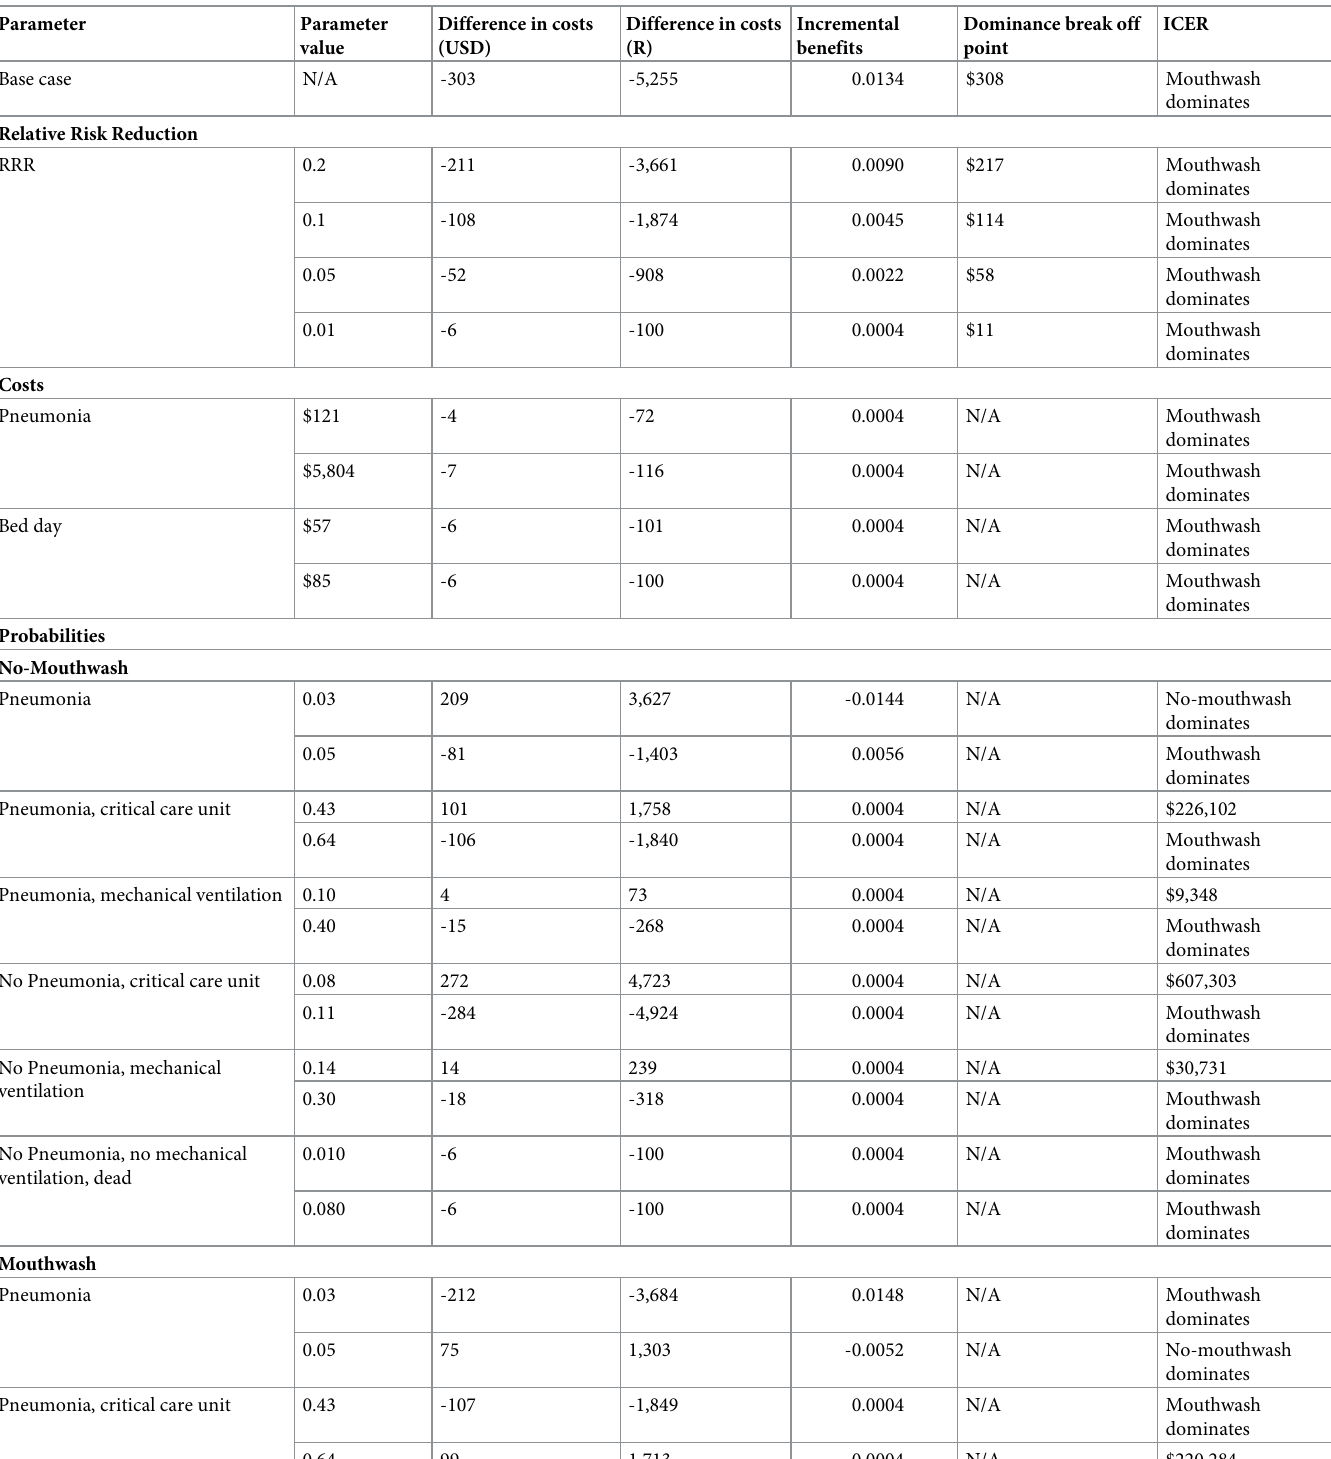
Table 7. Scenario 2 deterministic sensitivity analysis